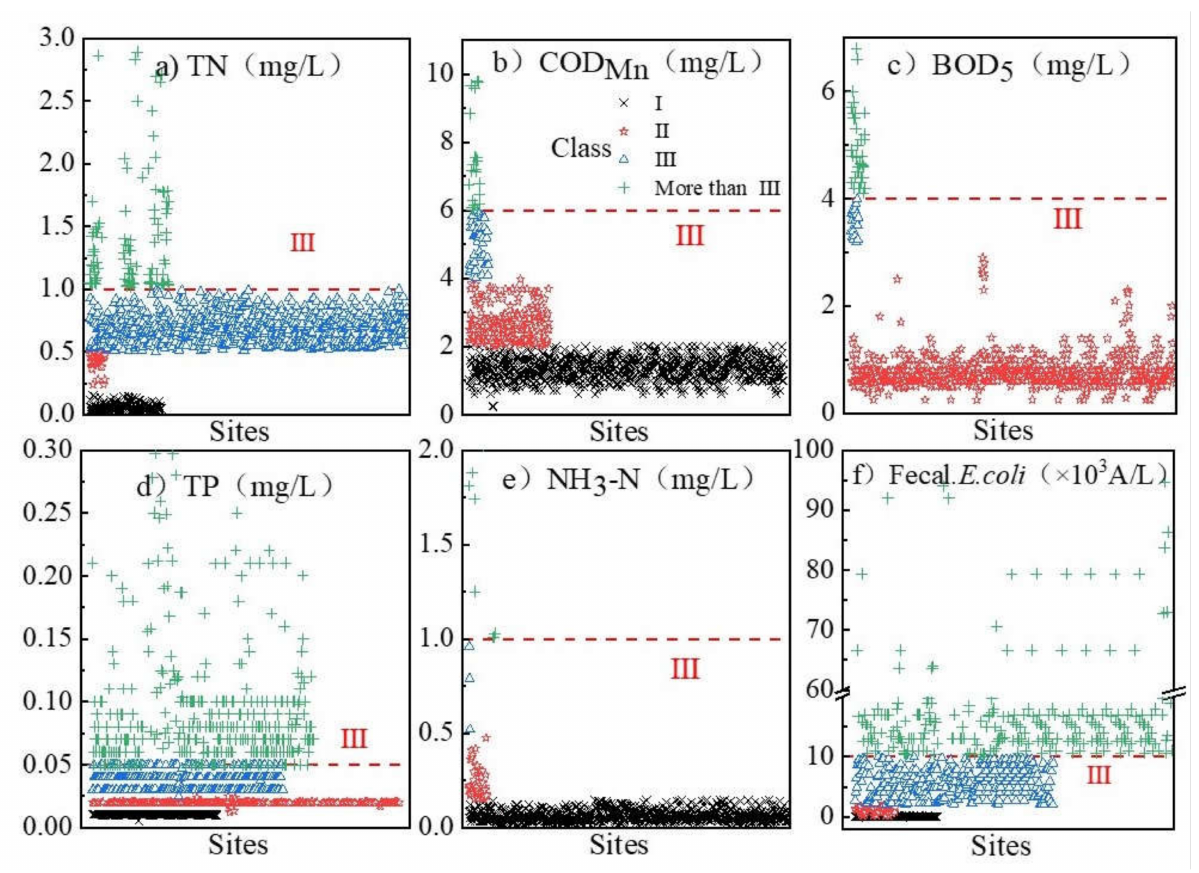
Figure 3. ( a ) TN, total nitrogen; ( b ) COD Mn , potassium permanganate index; ( c ) BOD 5 , five-day